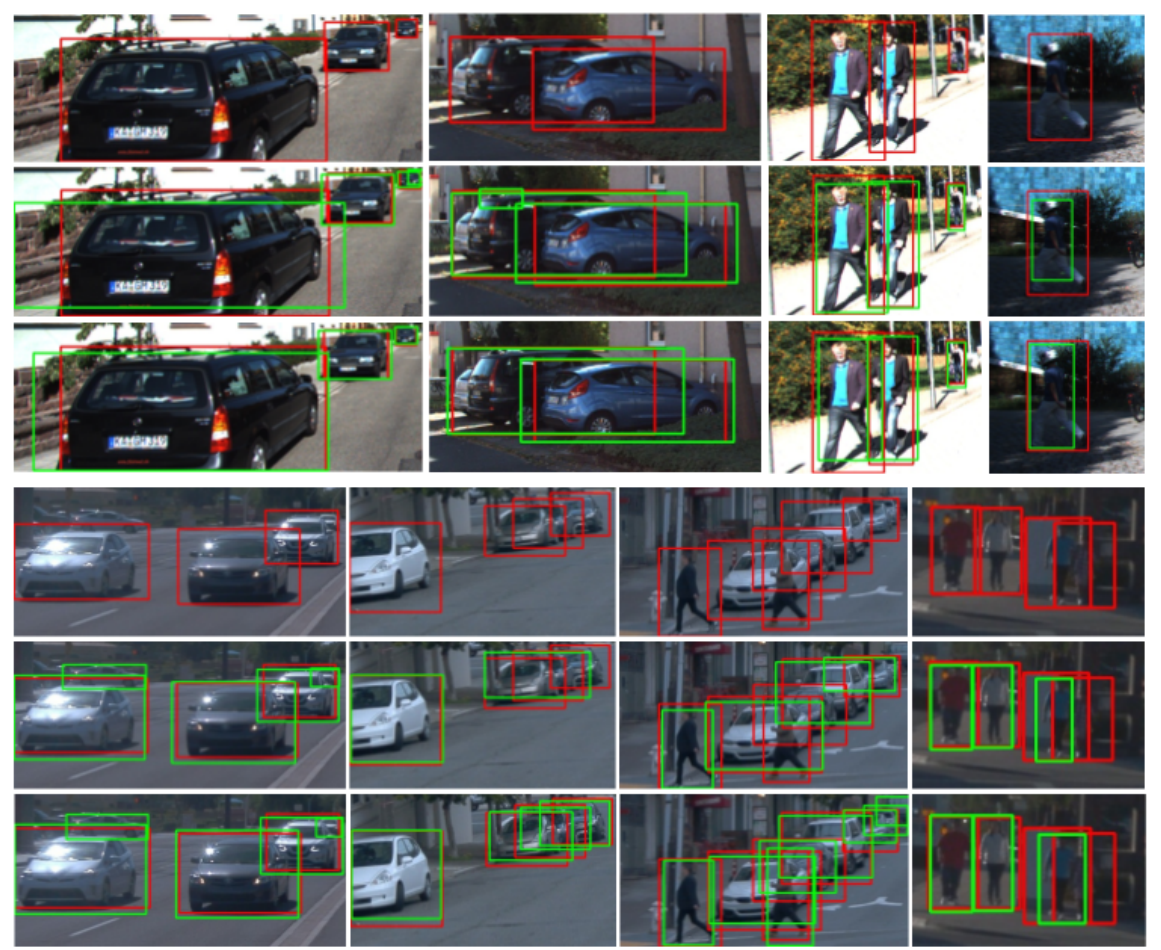
Figure 8. Qualitative results on K tt (top block of rows) and W tt (bottom block of rows). In each block, we show (top row) GT as red BBs, (mid row) detections, as green BBs, when training with X l , (bottom row) detections with X l Y X ˆ l . In this case, X ˆ l comes from applying C-T (RGB/D) on either K tr or W tr , and X l is V G